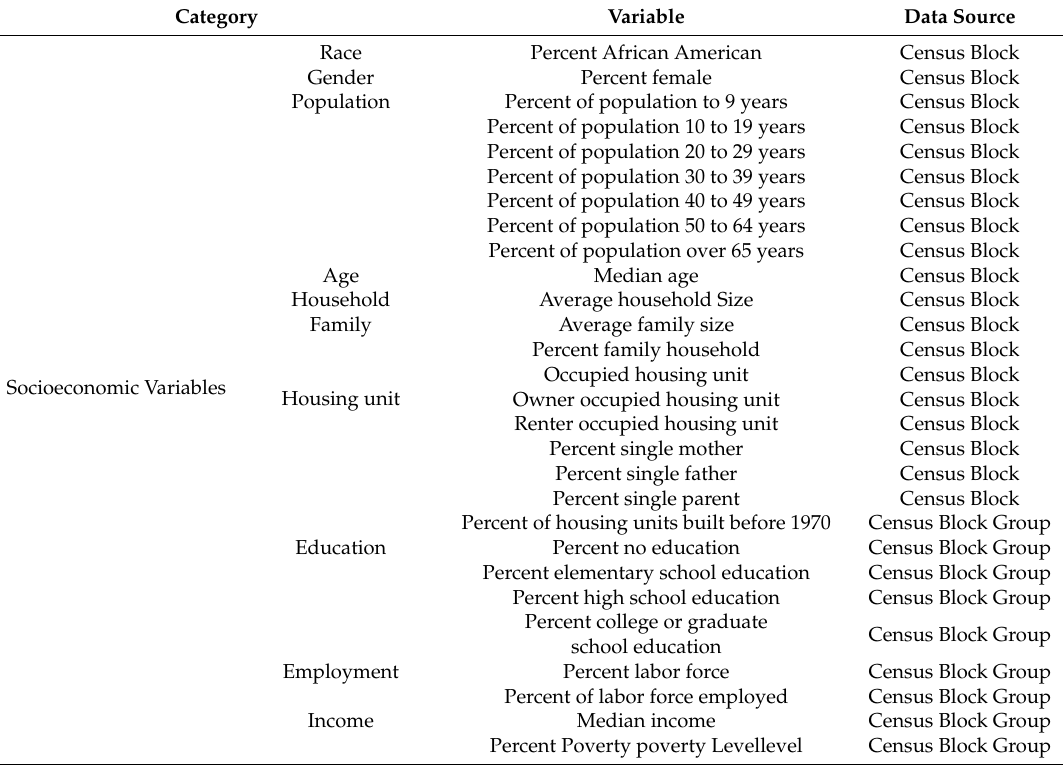
Table 2. List of socioeconomic variables used for the regression